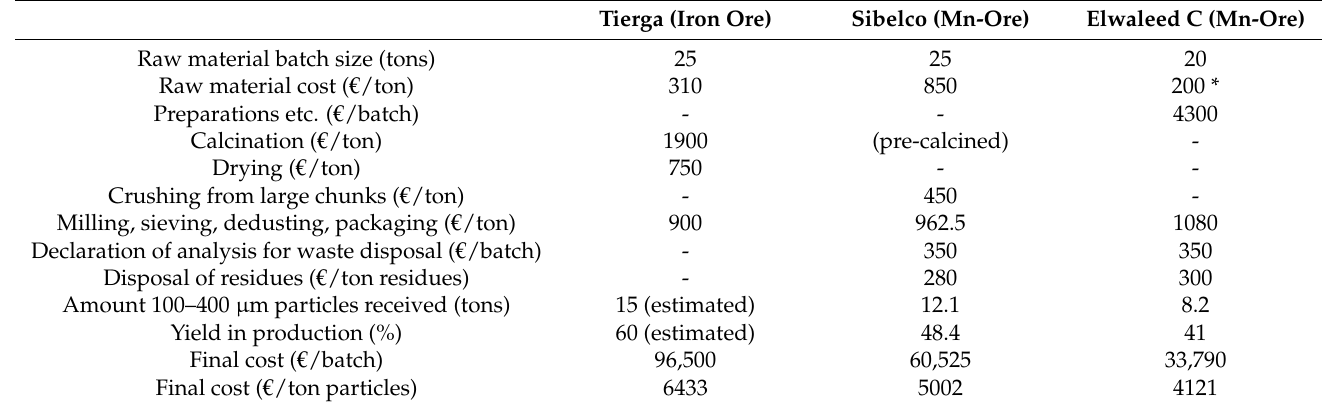
Table 5. Costs for large-scale preparation of oxygen-carrier particles. Note that these are costs for preparation of one large batch for experimental purposes. Economics of scale and learning curve are likely to reduce these costs significantly for a dedicated manufacturing process. Tierga (Iron Ore) Sibelco (Mn-Ore) Elwaleed C